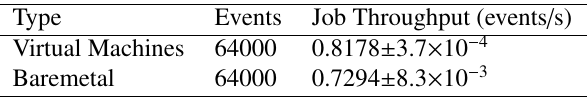
Table 1. Initial results for CMS digitization benchmark. The throughput is expressed as "mean ±